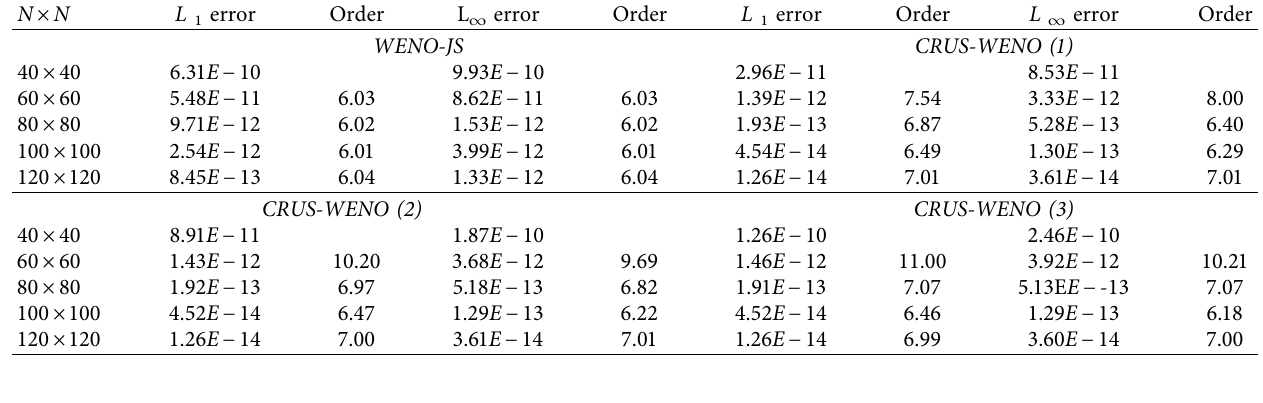
Table 2: Example 2. 2D heat equation. L